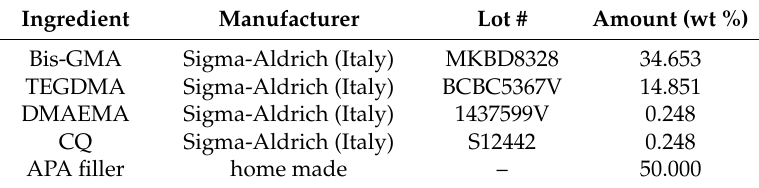
Table 1. List of all the ingredients (in short names) of the experimental APA-based composite